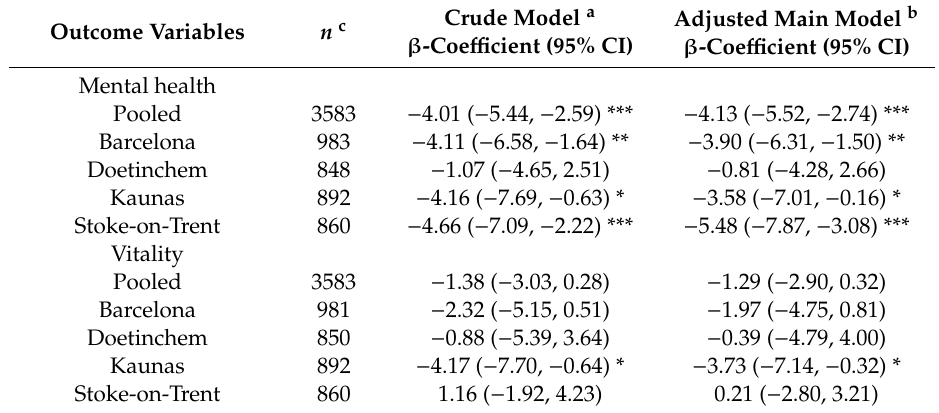
Table7. Mixede ff ectsregressionofchildhoodNOEexposure(lowlevelsvs. highlevels)onmentalhealth and vitality (0–100 scales; higher is better mental health / vitality). Pooled and city-specific